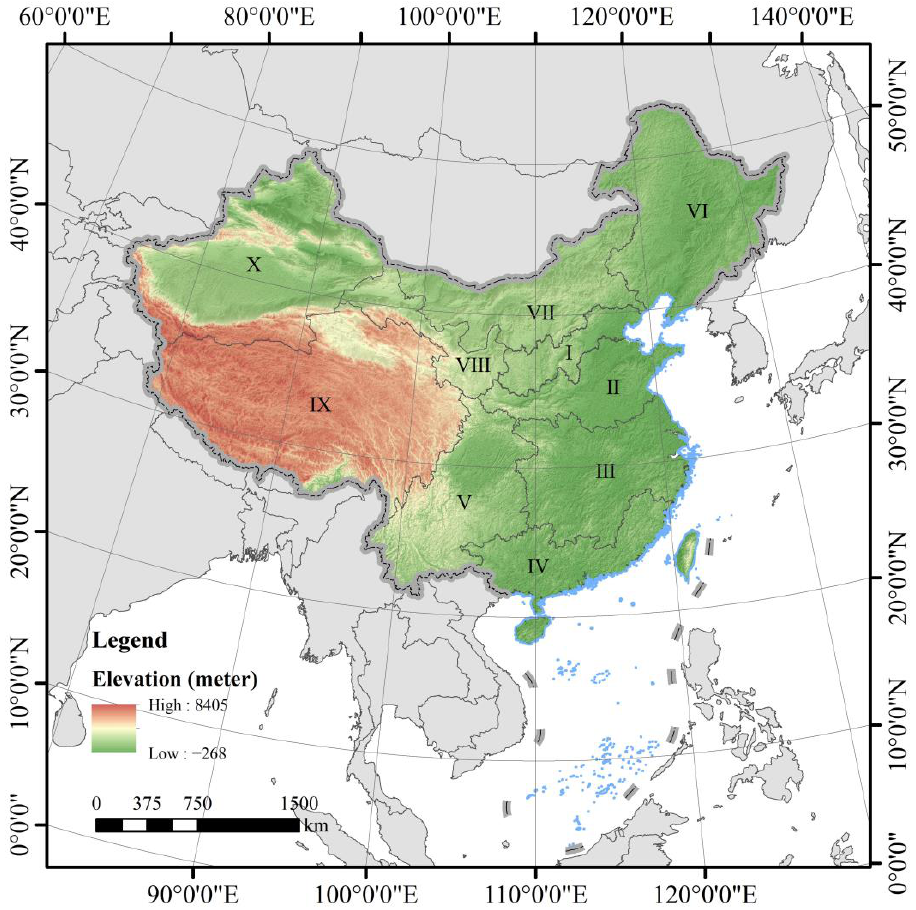
Figure 1. The geographical location of the study area. Major agro-ecological zones of wheat in China are indicated by Roman numerals [30]. Adapted with permission from Ref. [30]. 2009, Elsevier. The Digital Elevation Model (DEM) of China is available from the Resource and Environmental Science and Data Center.